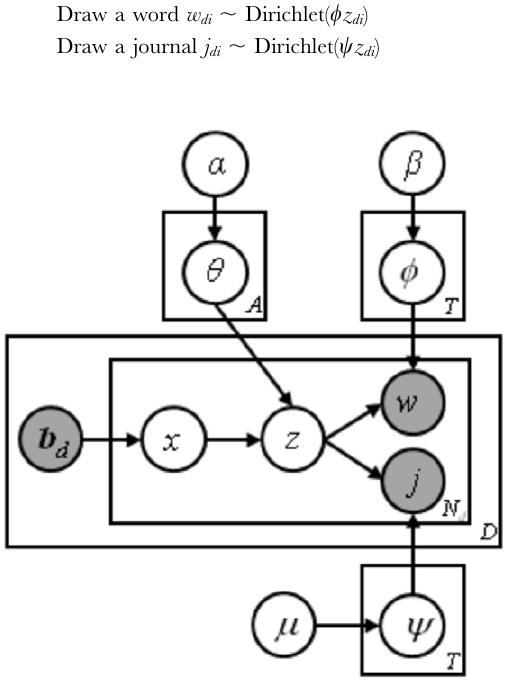
Figure 2. Graphical representation of the Bio-LDA models. doi:10.1371/journal.pone.0017243.g002 PLoS ONE |